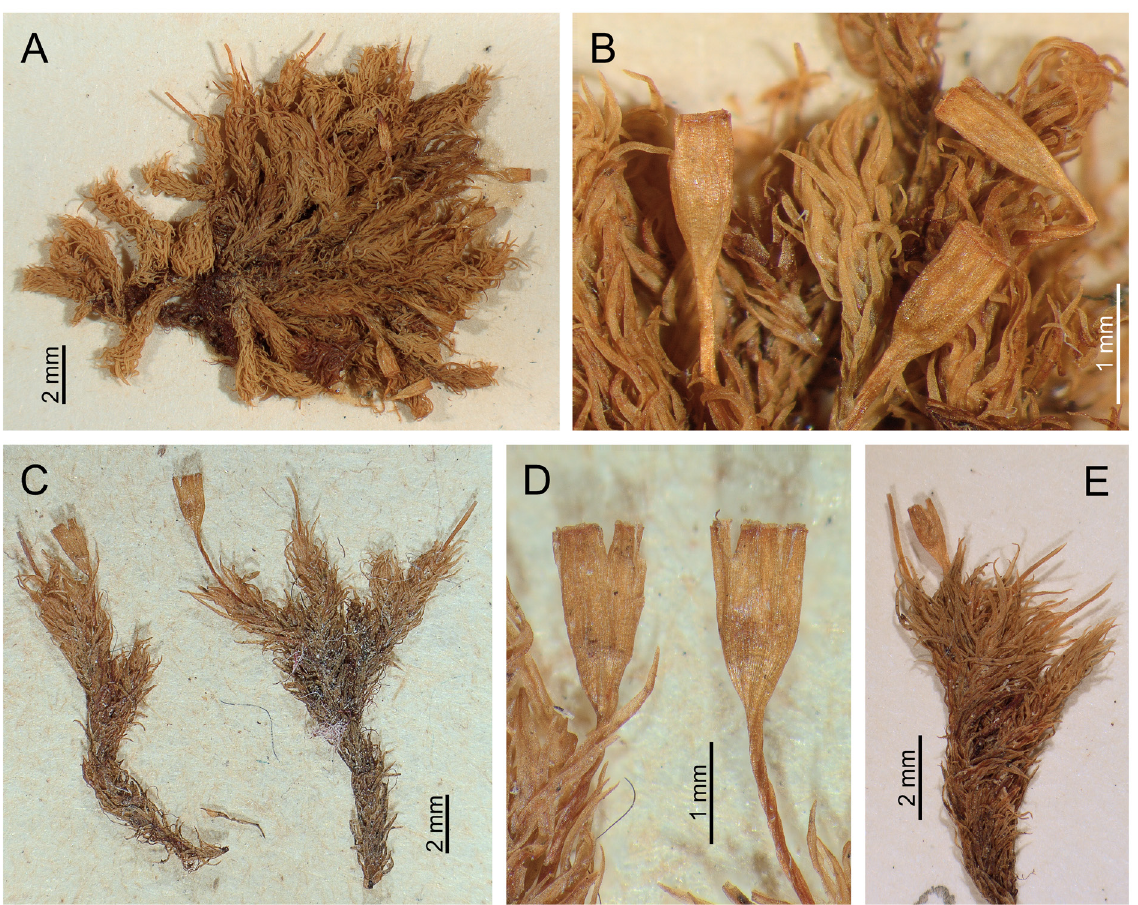
Fig. 1. Examples of the conservation of the type material of Ulota glabella Mitt. A – D . Holotype, consisting of a single specimen in two sheets (A–B from NY[00737690]; C–D from NY[00737691]). E . Isotype (PC[PC0101534]). Photographs by R.